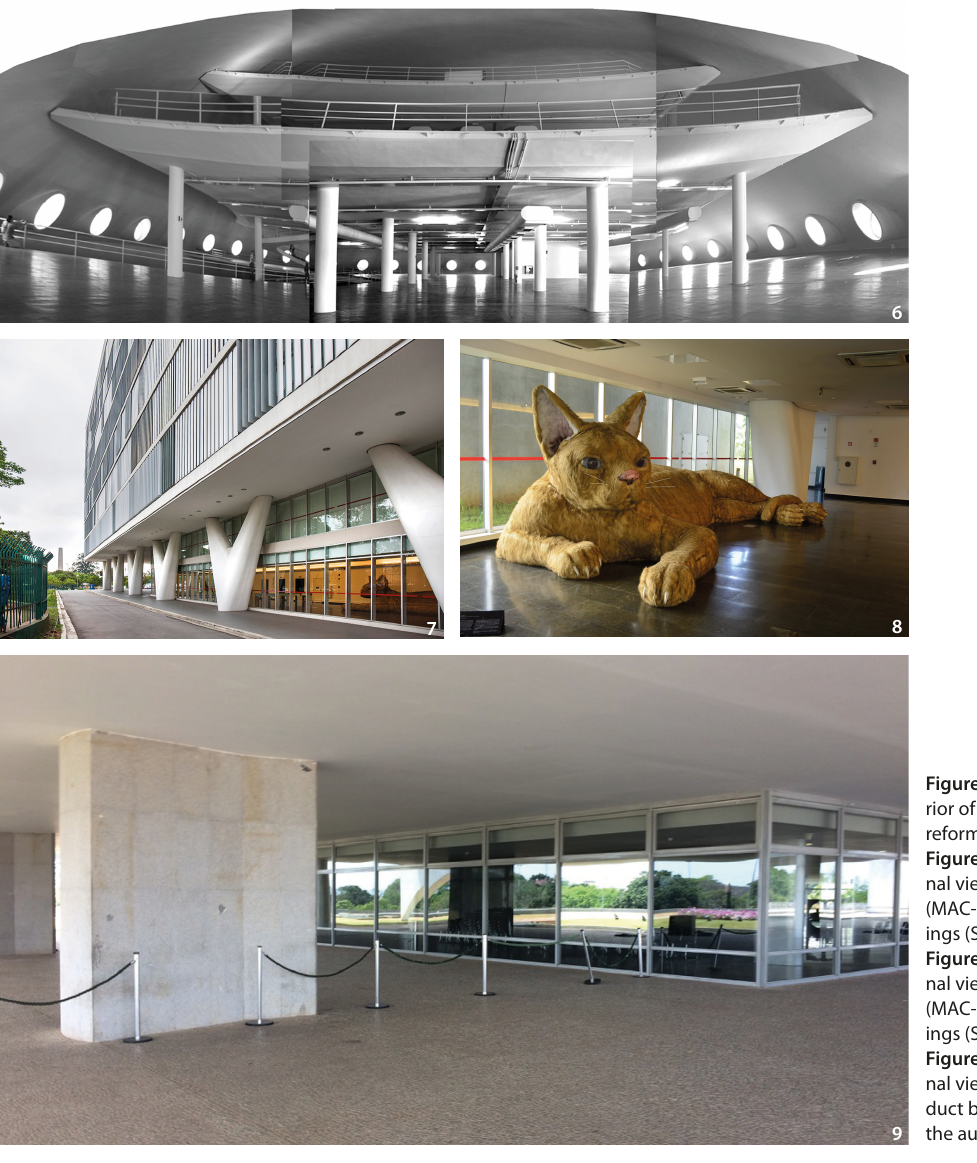
Figure 6 Oscar Niemeyer, inte- rior of Palace of Arts (Oca) after reform (Source: Ruth Verde Zein). Figure 7 Oscar Niemeyer, exter- nal view of Palace of Agriculture (MAC-USP) with dropped ceil- ings (Source: the author). Figure 8 Oscar Niemeyer, inter- nal view Palace of Agriculture (MAC-USP) with dropped ceil- ings (Source: the author). Figure 9 Oscar Niemeyer, exter- nal view of Planalto Palace with duct behind glass wall (Source: the